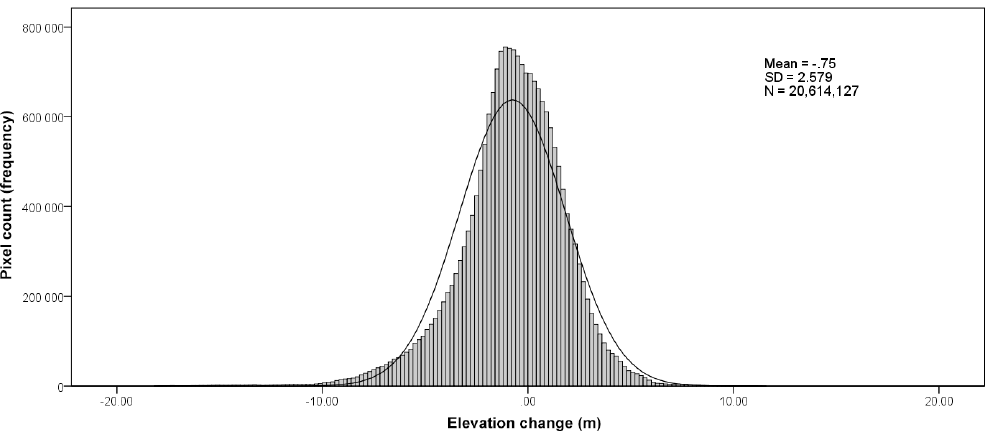
Figure 8. Histogram of measured elevation changes over glacier tongue (blue boundary in Fig. 7) from 23 July 2014 to 28 July 2015. Calculated from subtraction of 2014 DEM from 2015 DEM (i.e. negative values are ice loss) at 10cm DEM pixel